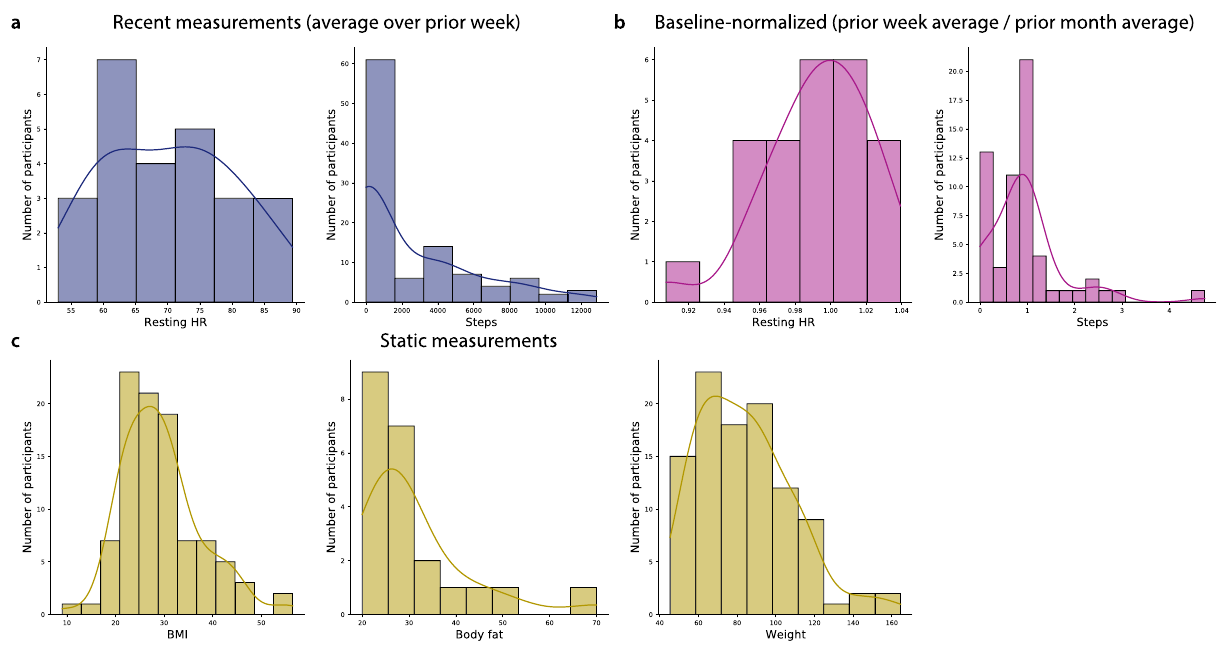
Figure 4. Fitness measures. ( a ) Recent measures. Resting heart rate (HR) and daily step counts, averaged over the week prior to testing. ( b ) Baseline-normalized measures. Resting heart rate and daily step counts averaged over the week prior to testing, divided by the average resting heart rate and step counts averaged over the preceding month. ( c ) Static measures. Body mass index (BMI), body fat percentage, and weight (in kg). For more information see Figs. S6, S7, S8, S9, and